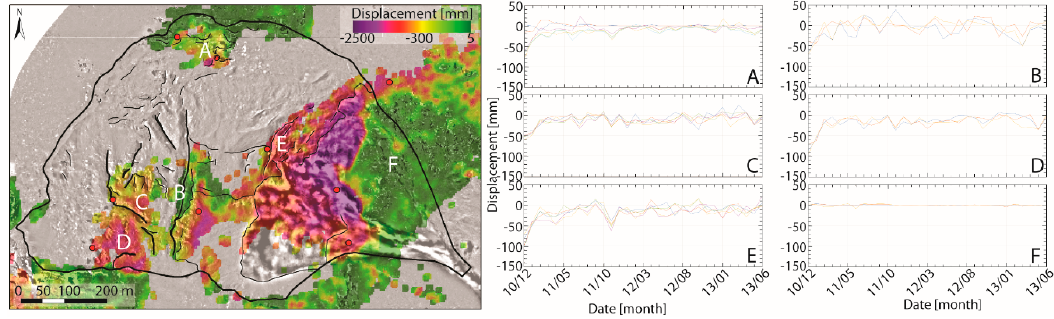
Figure 13. Total GB-InSAR displacements over the RTS15 × 15 map and main displacements of the A–F areas.